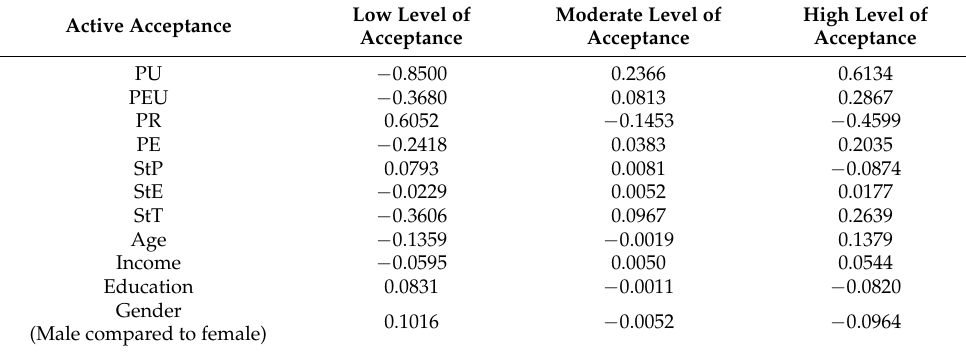
Table 5. Marginal effects (active